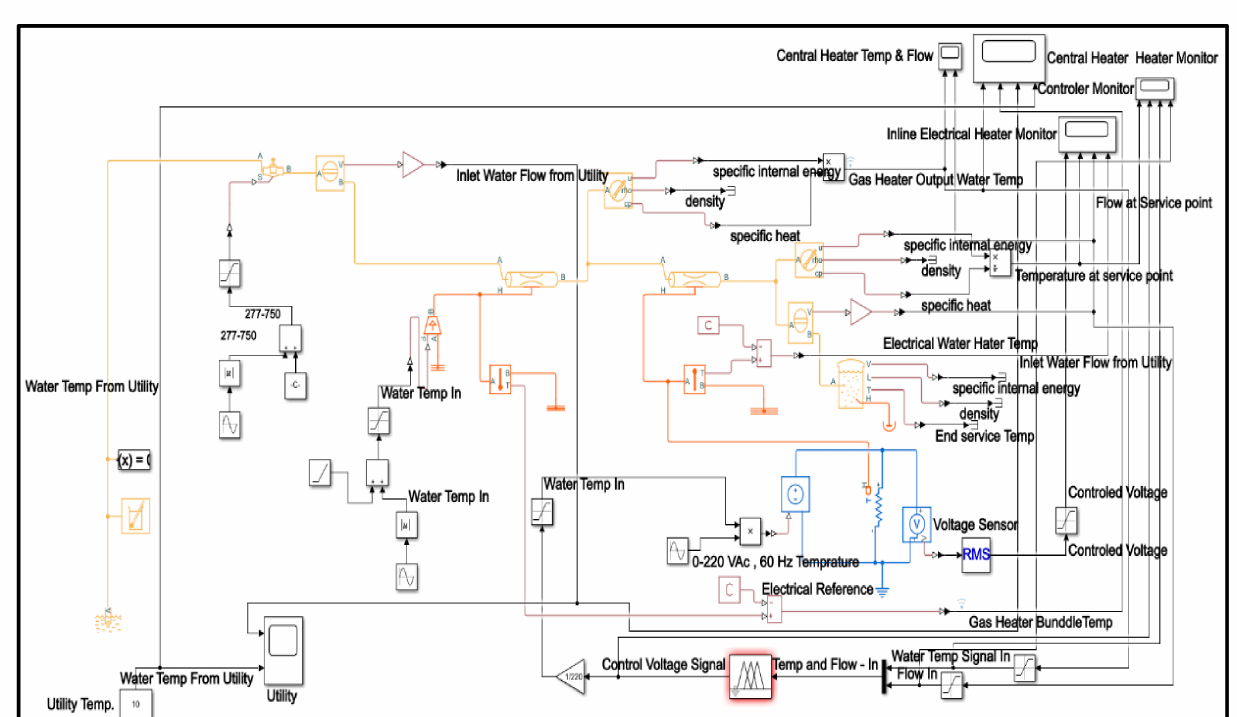
Figure 6. Simulink